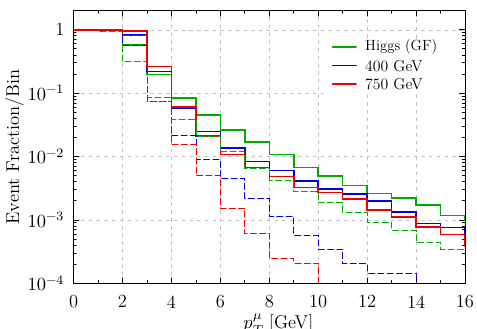
Figure 3. Complementary cumulative distribution for the p T of the hardest (second hardest) muon for various benchmarks indicated by solid (light dashed) curves. Production through gluon fusion was assumed for the Higgs